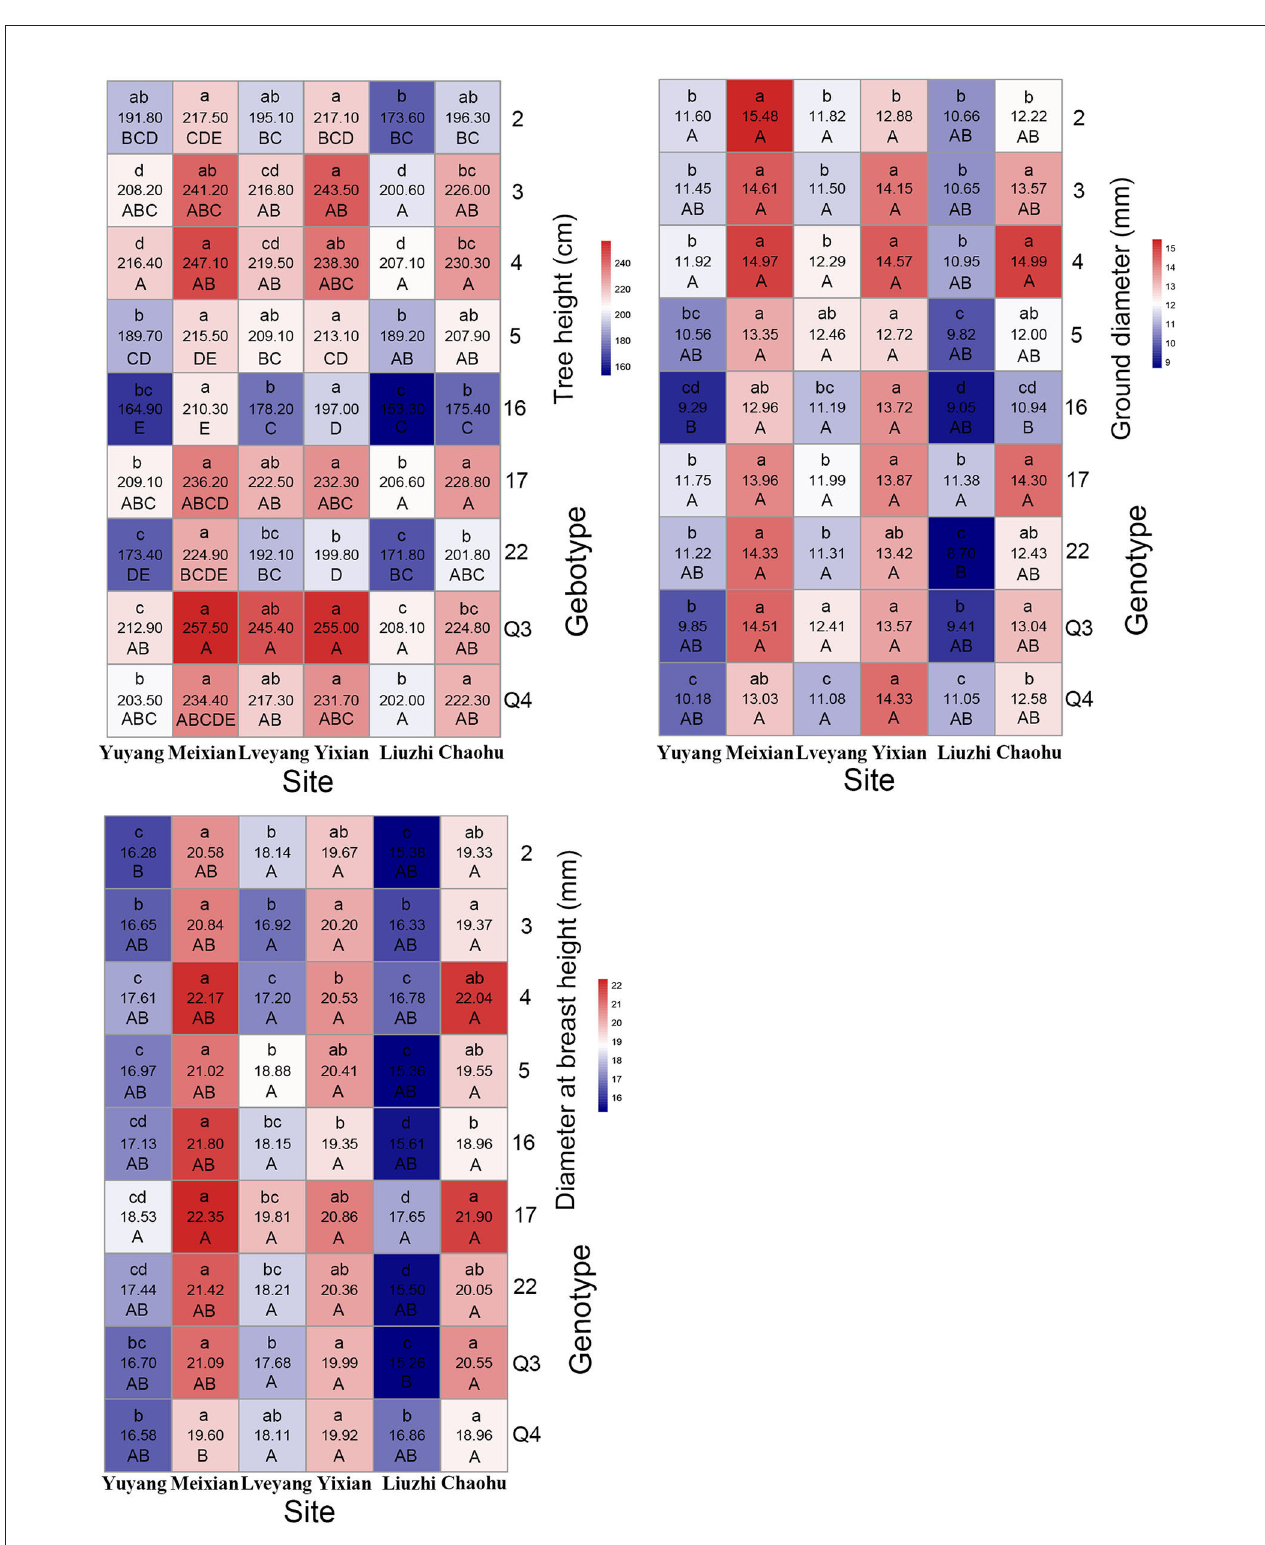
FIGURE 4 | Mean heat map of growth traits (refer to the details in the Figure 3 legend).